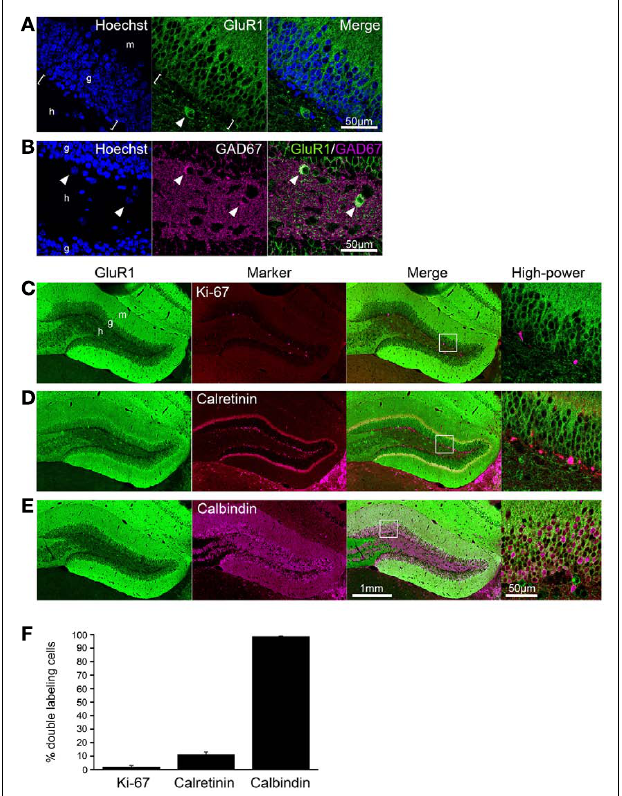
FIGURE 1 | GluR1 expression in mature granule cells. (A,B) GluR1 immunoreactivity was abundant in the granule cells and hilar interneurons (arrowheads) in the adult dentate gyrus (A) . Note that there was no GluR1 immunoreactive signal in the subgranular zone [brackets in (A) ]. Some interneurons labeled with GluR1 antibody in the hilus were GAD67-positive [arrowheads in (B) ].To visualize the nucleus, cells were counterstained with Hoechst. (C–E) Co-labeling of GluR1 with Ki-67, neural progenitor cells (C) , calretinin, immature granule cells (D) or calbindin, mature granule cells (E) . Higher magnifications of the boxed-in area in the merged images are shown on the right-hand side. (F) The co-labeled cells were quantified. Values are given as the mean ± SEM of the analysis based on the results of three mice. g, Granule cell layer; h, hilus; m, molecular layer.